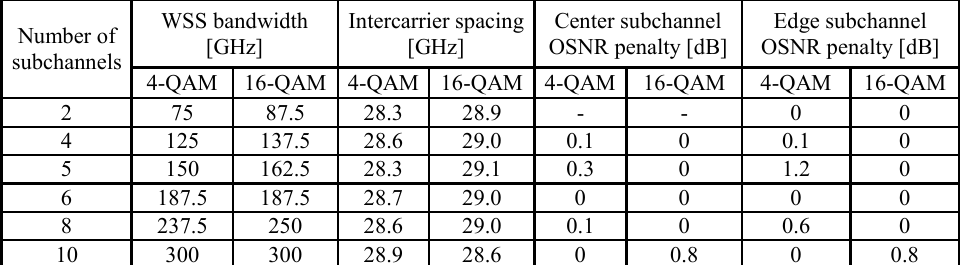
Table 1. Intercarrier spacing and the lowest OSNR penalty after 20 cascaded WSSs for 28 GBd with 𝜌 =0.1, 4-QAM and 16-QAM modulation formats, for a different number of subchannels in the superchannel.